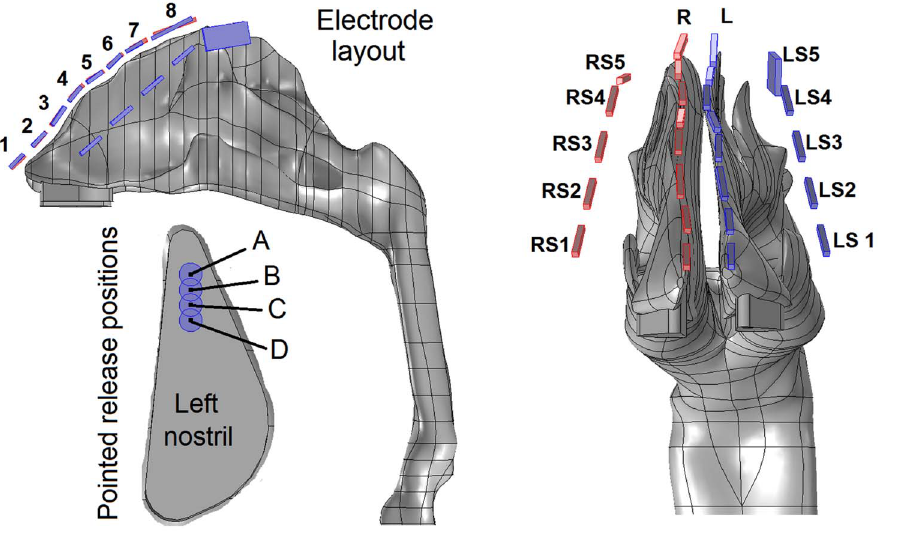
Figure 6. Diagram of electrode configuration and four particle-pointed-release positions. There are four groups of electrodes in tandem, with one group on each side of the nose and one group lining above each of the two nasal ridges. L: left; R: right; LS: left side; RS: right side.